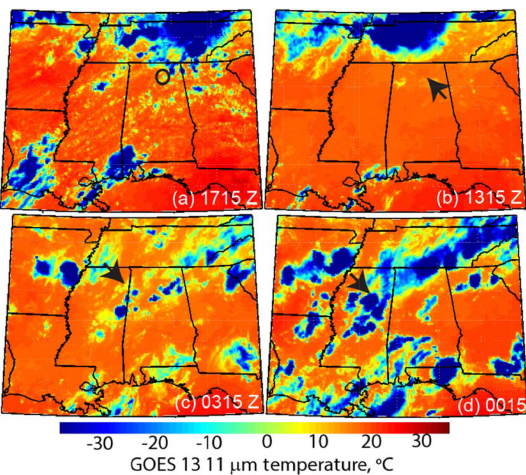
Figure A3. GOES 13 11µm channel images of the storm leading to AC clouds in the Huntsville lidar data in Fig. 5. (a) PBL detrained AC clouds on 12 August 2013, 17:15Z; (b) initiation of back tra- jectory for 0 ◦ C cloud; (c) 10h back trajectory endpoint to large detrainment shelf; (d) Cb that formed the AC